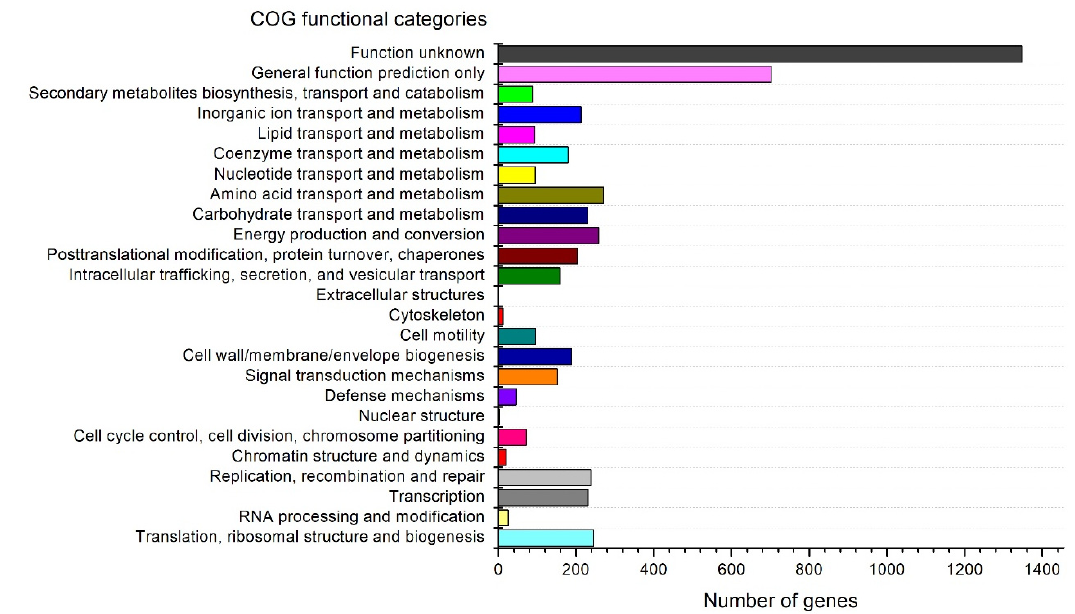
Figure 4. COG functional classification of proteins in strain S-51 T genome.